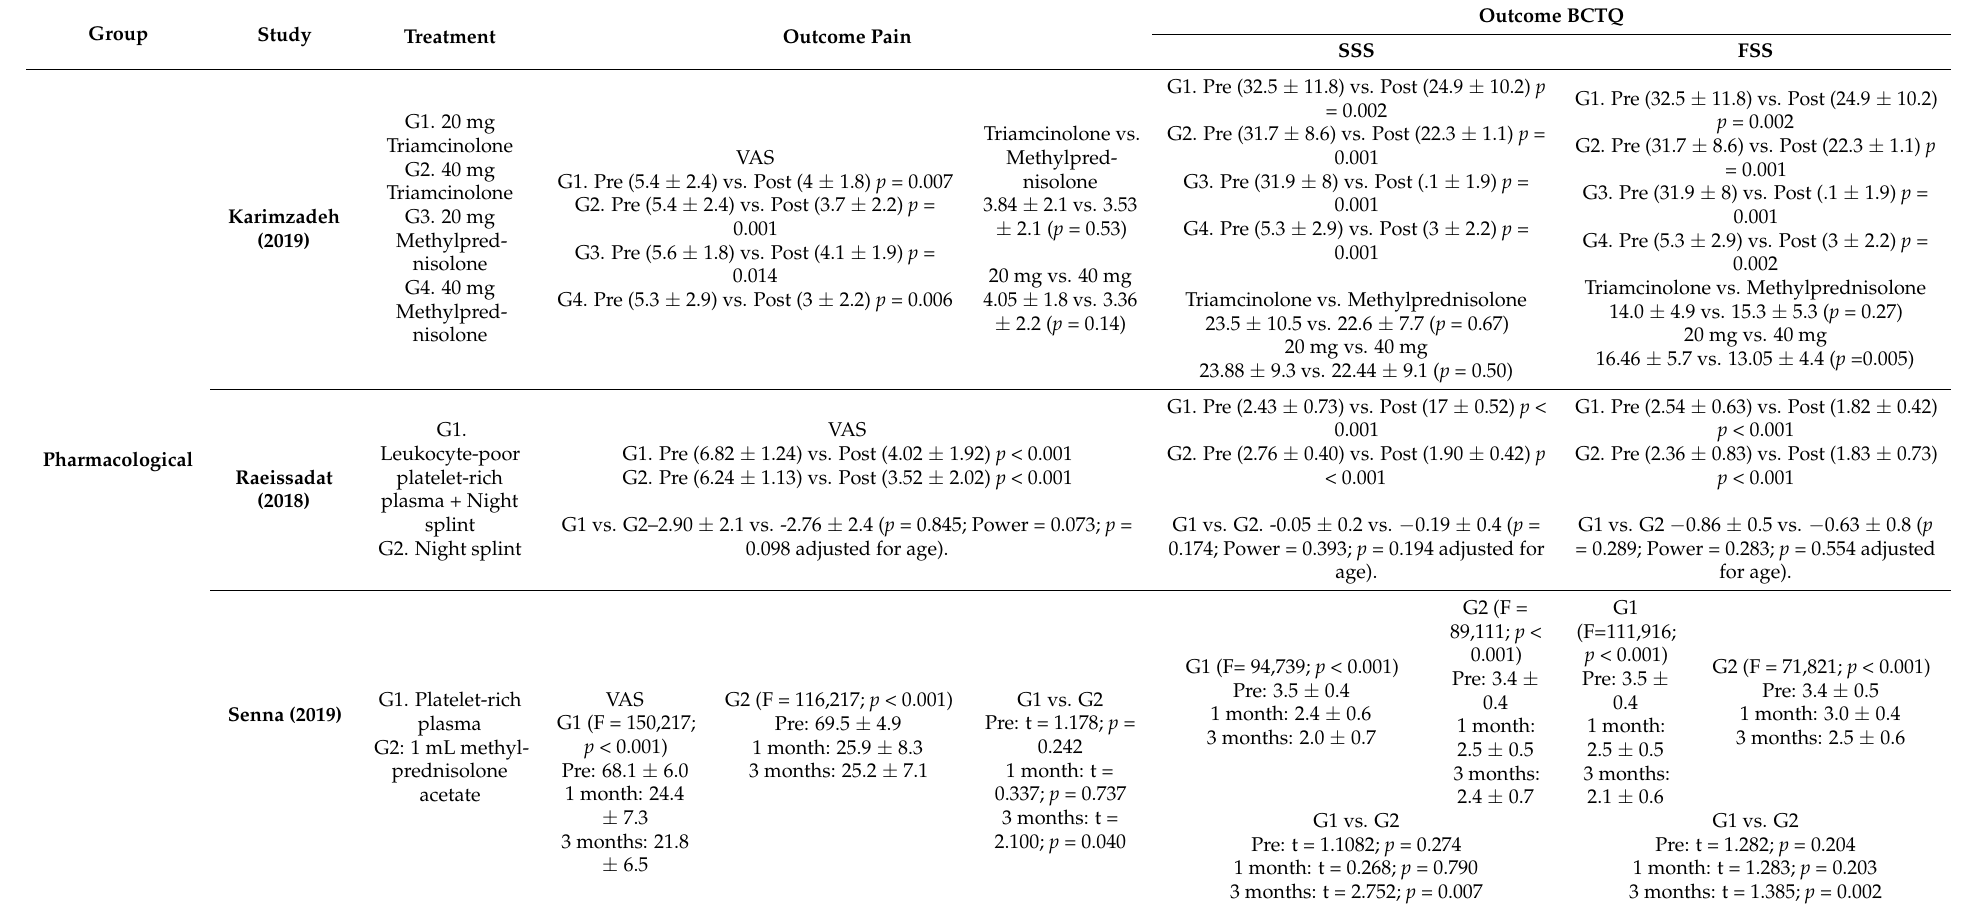
Table 4. Pain and BCTQ Results of